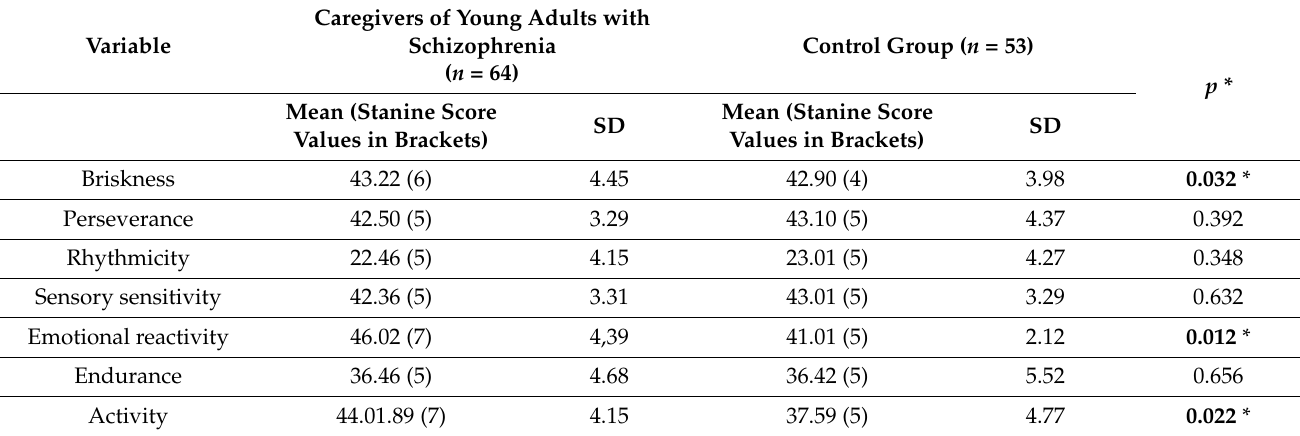
Table 2. Analysis of differences in temperamental traits according to the Regulatory Theory of Temperament between caregivers of young adults with schizophrenia and the control